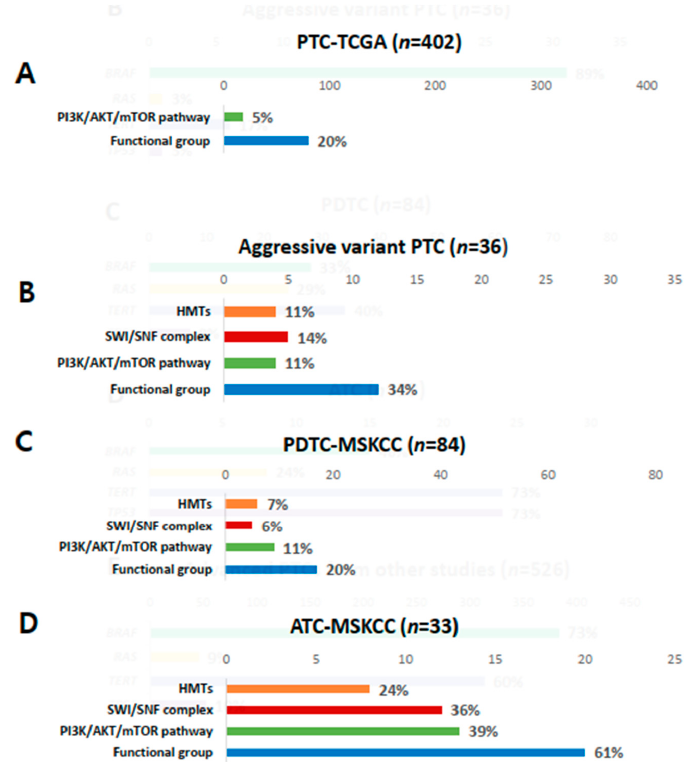
Figure 3. Comparison of mutations in histone methyltransferases (HMTs), switch/sucrose non- fermenting (SWI/SNF), the PI3K/AKT/mTOR pathway, and total functional groups. ( A ) Papillary